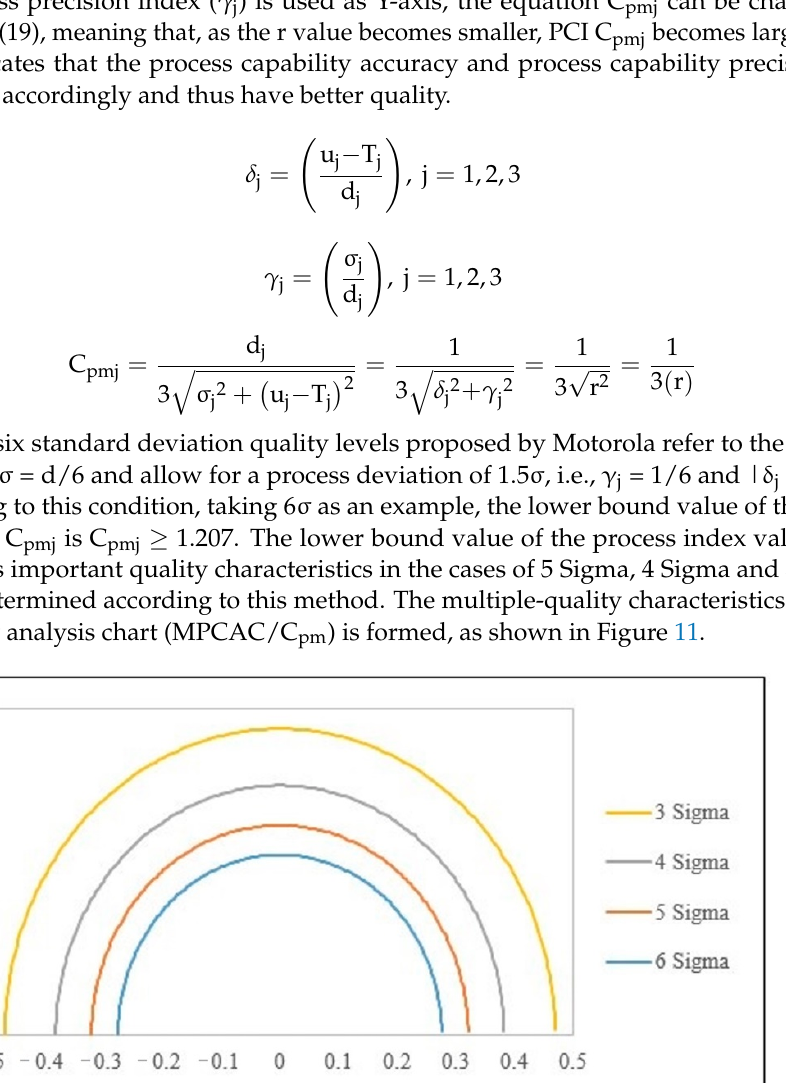
14.95 The quality S/N ratio values in Table 3 were substituted into Equations (2)–(6). The quality characteristics were used in the variation analysis, and the following significant factors in screw mixing were obtained: the tensile strength is B, C, F and H; the impact strength is B, C, E and F; and the hardness is A, B, C and E. The significant factors in cyclone mixing are as follows: the tensile strength is A, B, C and F; the impact strength is C, E, F and G; and the hardness is A, B, C and H.